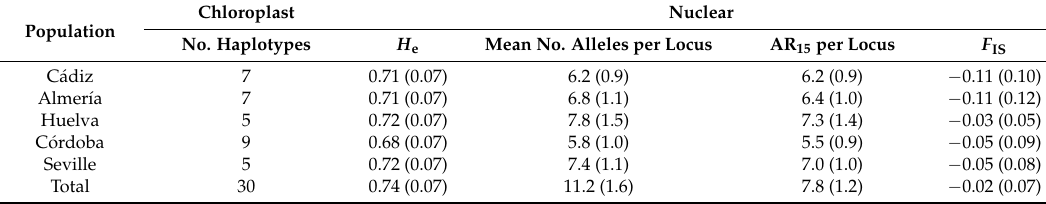
Table 2. Parameter estimates for chloroplast and nuclear microsatellite diversity in populations of Q. ilex from Andalusia, Spain. H e —expected heterozygosity; AR 15 —number of alleles on basis of a minimum population size of 15; F IS —inbreeding coefficient. Numbers in parentheses indicate standard errors of the